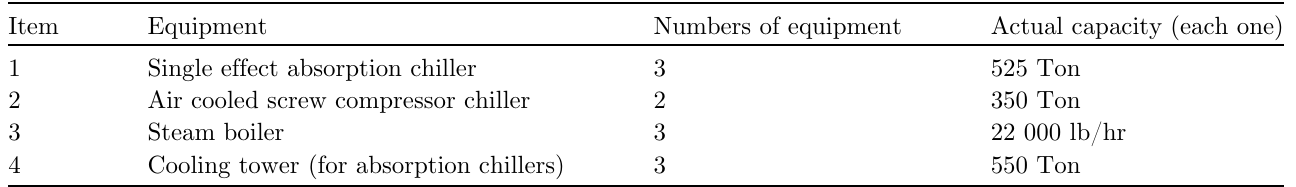
Table 2. Main equipment located in the mechanical of the Tehran heart hospital building. Item